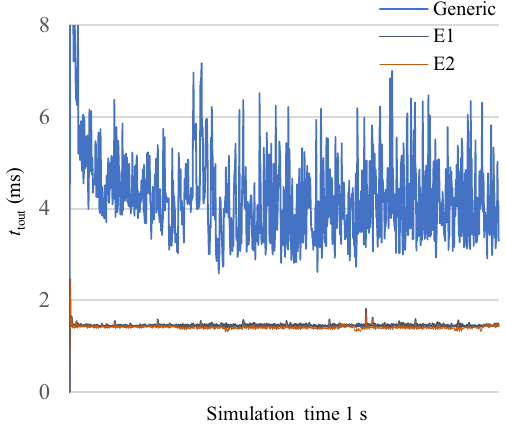
Fig. 15 Total time t tout from the simulation in every stage with a timestep of 1 ms for case